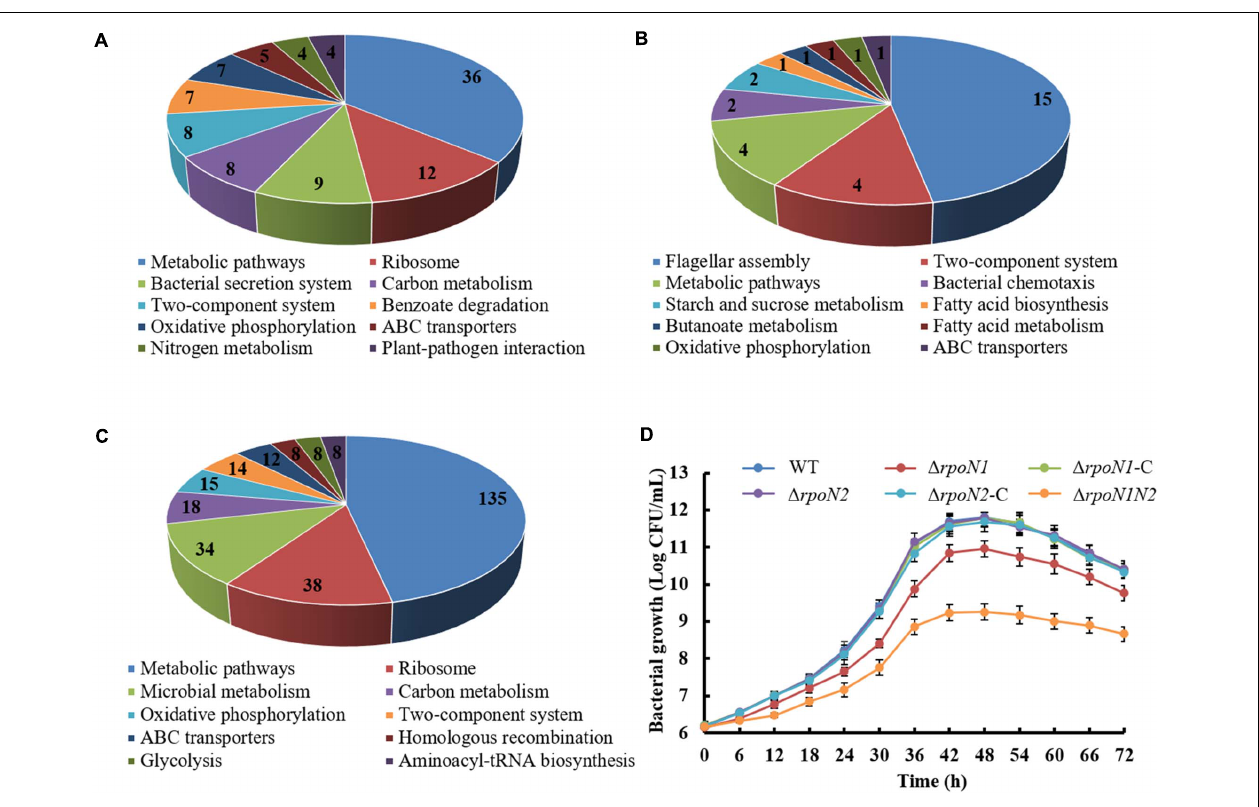
FIGURE 10 | Analysis of DEGs specifically regulated by RpoN1 or RpoN2. DEGs specifically regulated by (A) rpoN1 , (B) rpoN2 , (C) (cid:49) rpoN1N2. The number represents the number of DEGs enriched in KEGG pathways. (D) Growth curves of Xoo strain cultured using rich media M210. The growth curves were constructed three times, independently. Error bars indicate standard